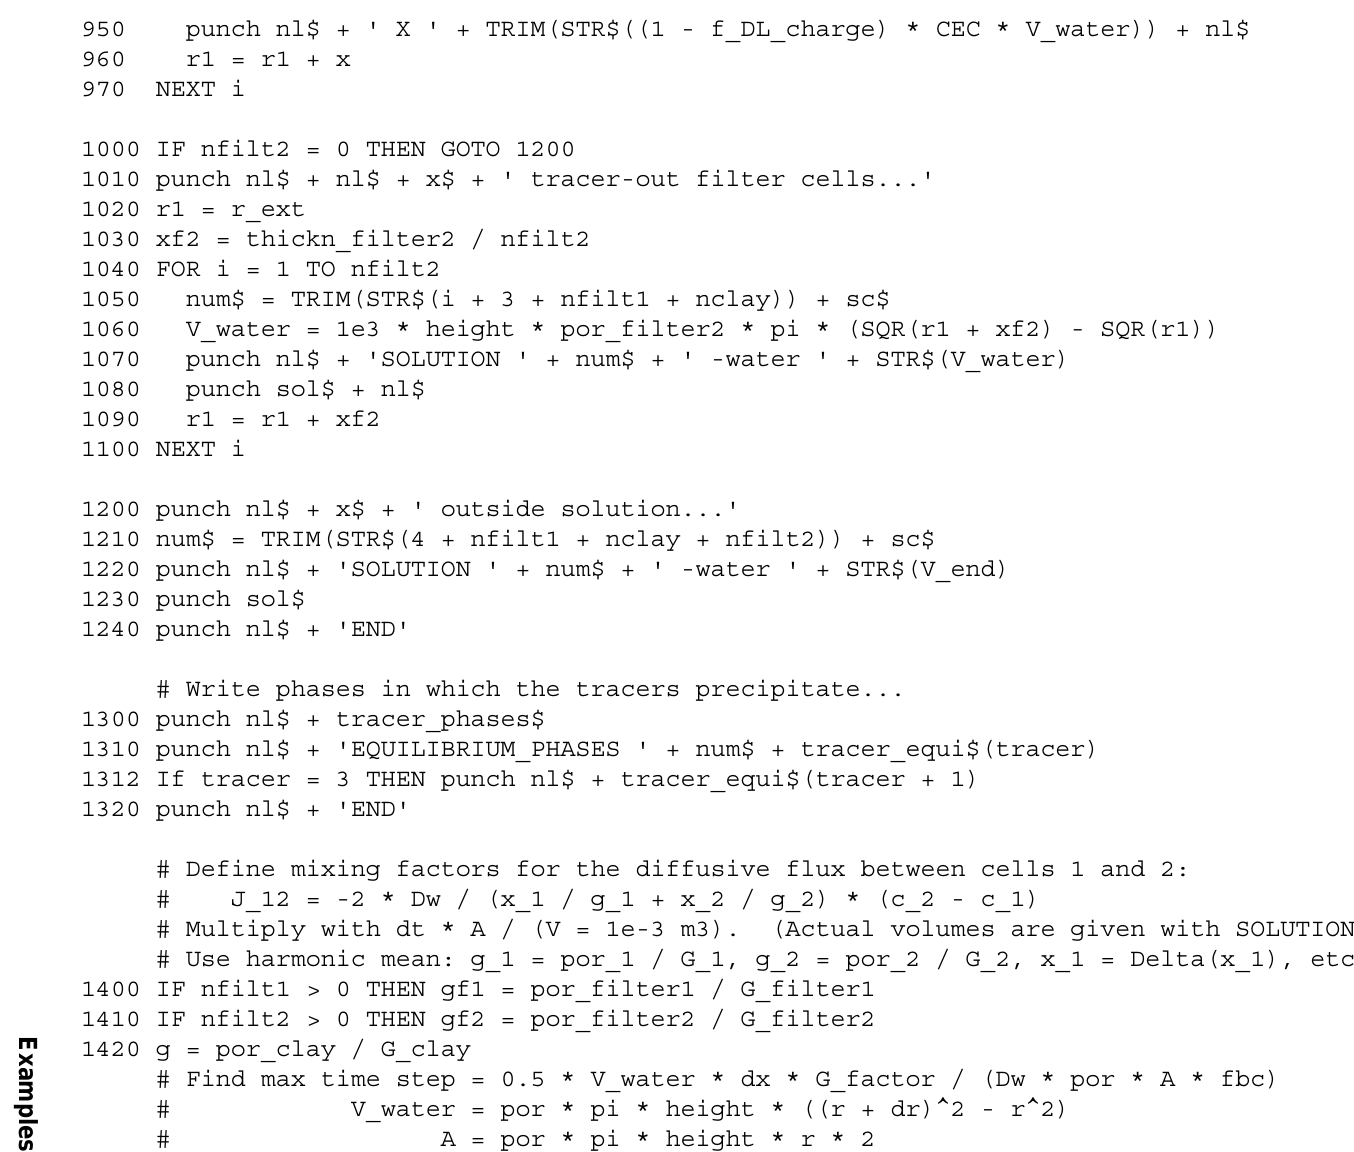
Table 60. Input file for example